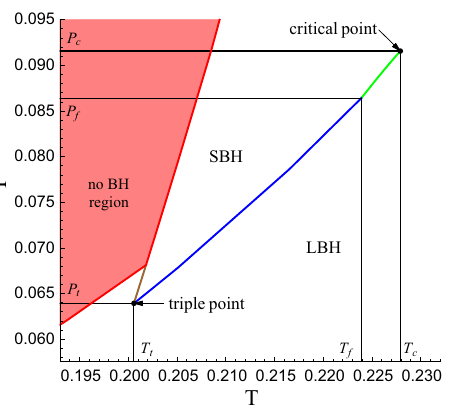
and SBH. On crossing the blue (brown) line, the system goes under a first (zeroth) order phase transition between SBH and LBH (SBH and IBH). In addition, on crossing the green line, the system undergoes a zeroth order SBH–LBH phase transition point. The behavior of the system for the other rows is just like the case investigated throughout this